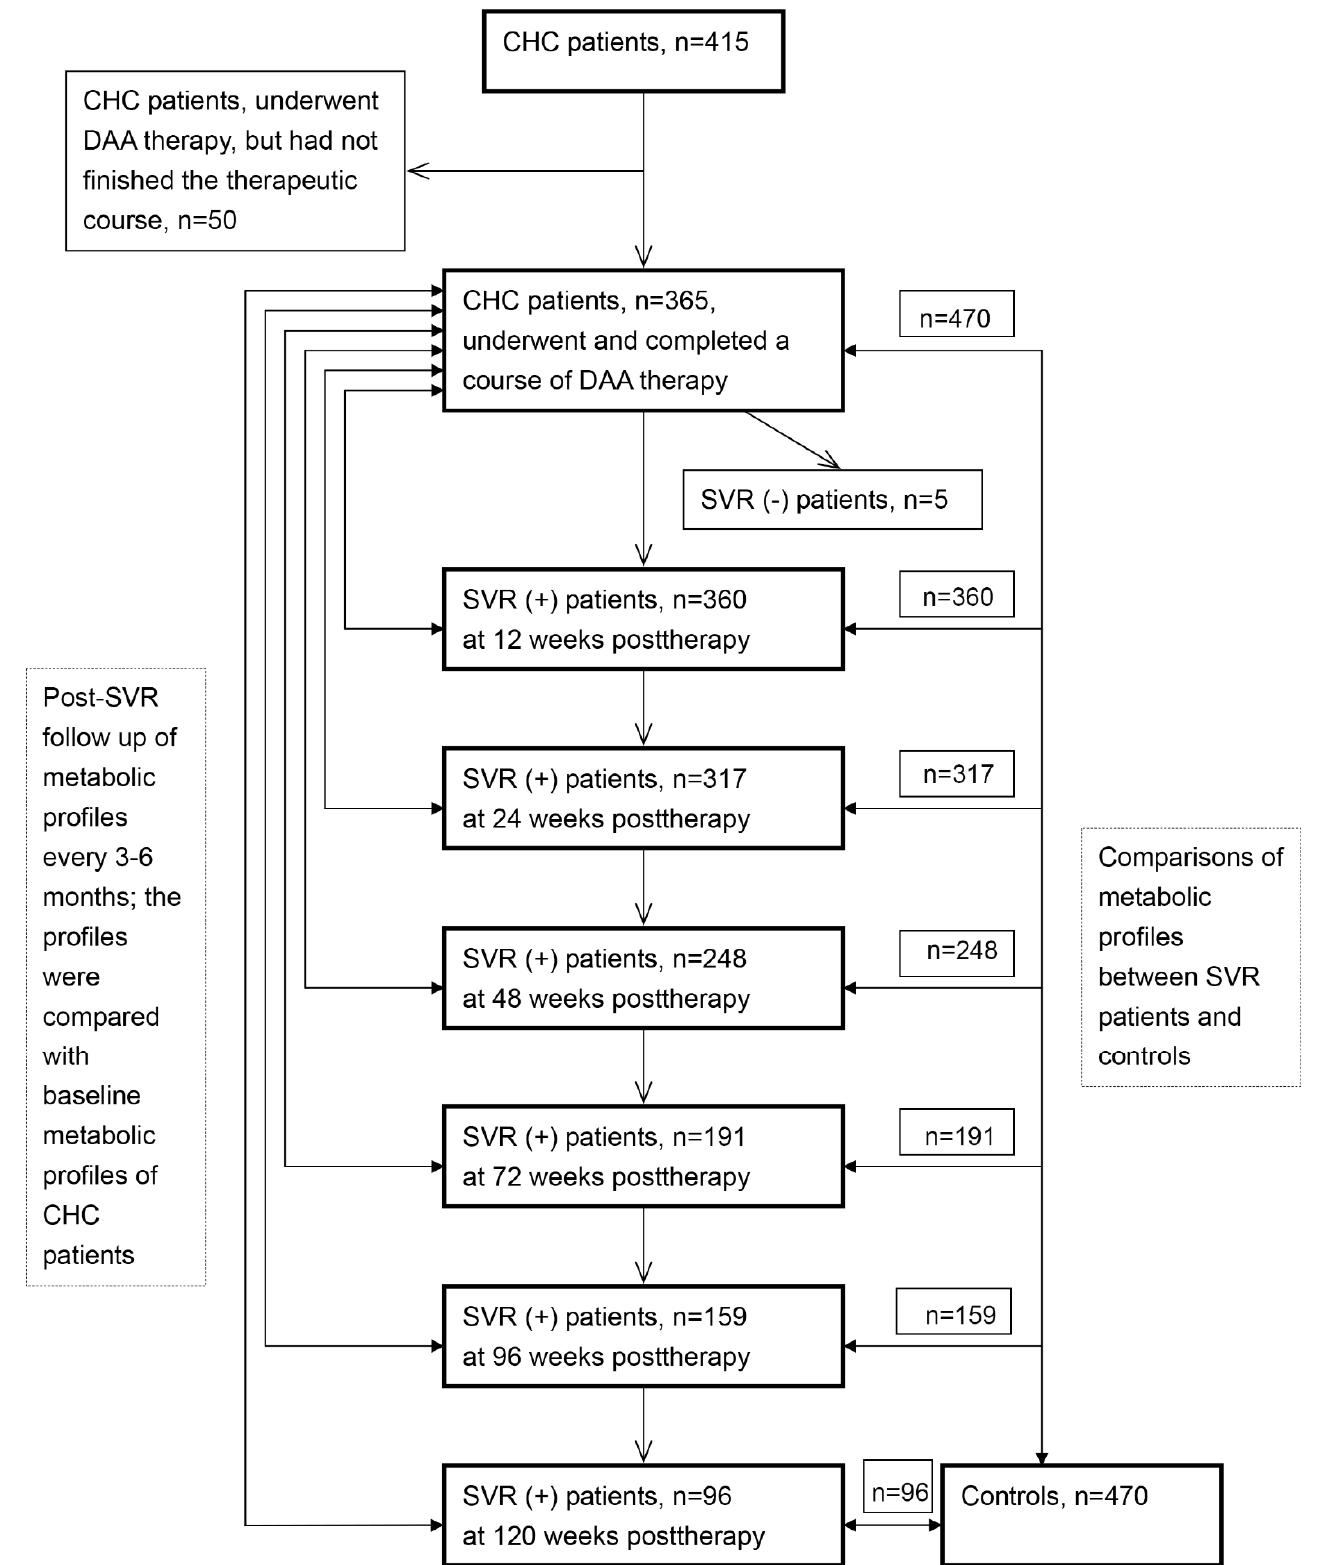
Figure 1. Schematic flow chart of the enrolled patients. CHC: chronic hepatitis C virus infection; DAA: direct-acting antiviral; SVR: sustained virological response.